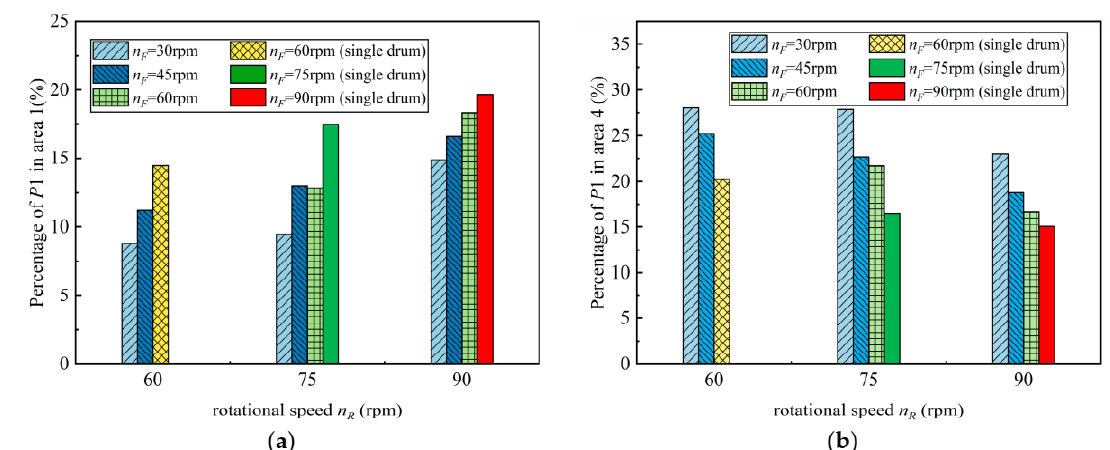
Figure 13. The P1 value in area 1 and area 4 under the same n R : ( a ) area 1; ( b ) area 4.